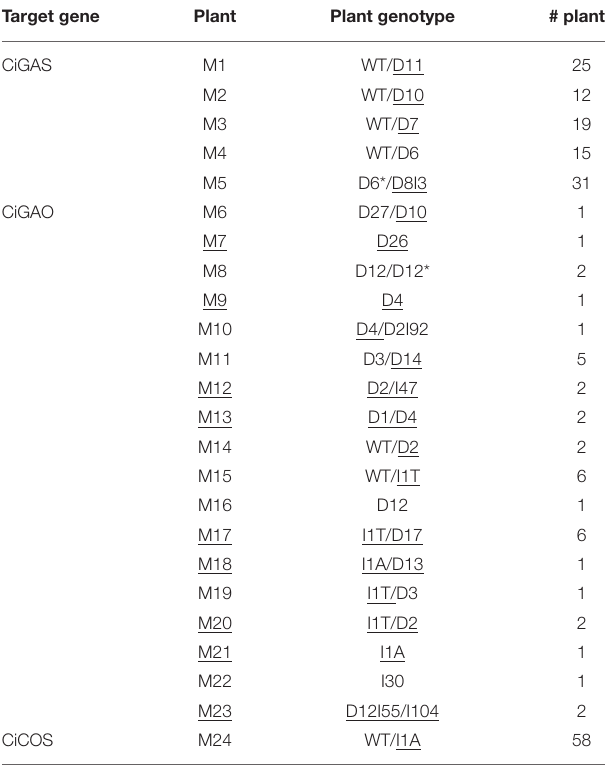
TABLE 6 | Overview and number of CiGAS , CiGAO and CiCOS mutated plant